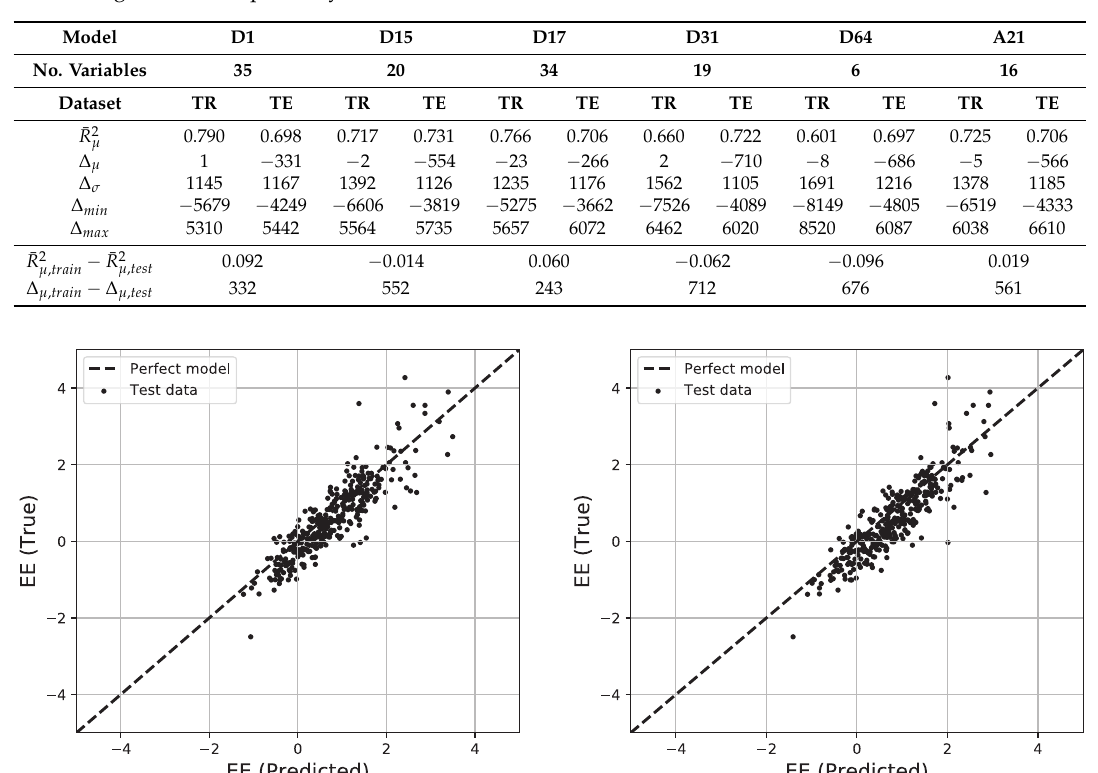
Figure 7. The predicted and true EE consumption. The dashed lines represent a perfect model where all predicted EE consumption values are equal the true EE consumption values. All values are normalized. Left: Model D15. Right: Model